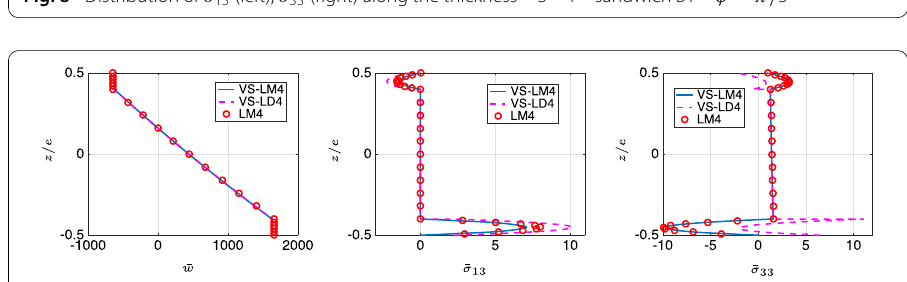
Fig. 8 Distribution of ¯ σ 13 (left), ¯ σ 33 (right) along the thickness—S=4—sandwich B1— φ = π/ 3